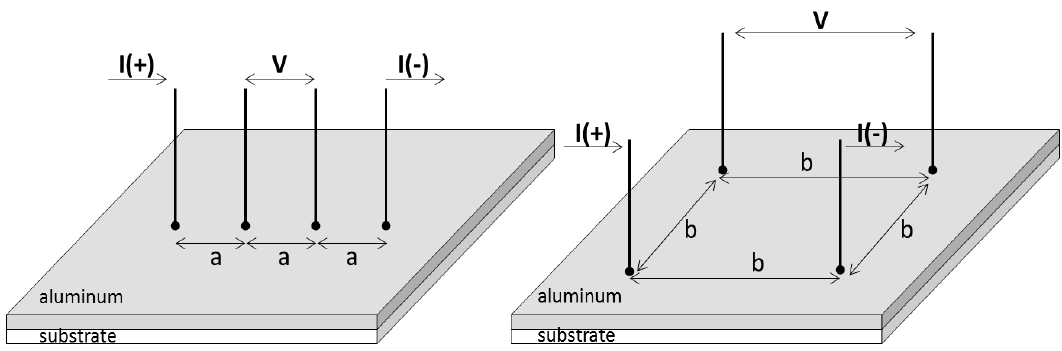
Figure 20. Common arrangements for measurement of surface resistance.